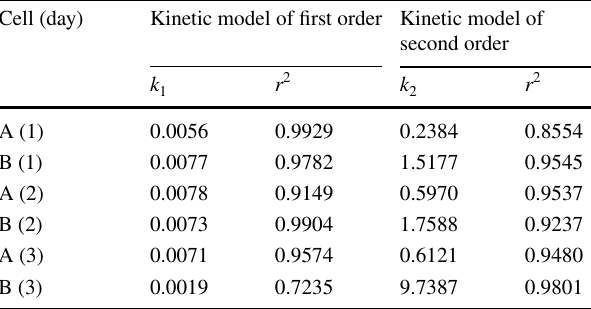
indicate that the DSSC with TiO more stable than pure TiO TiO photoelectrode. 2